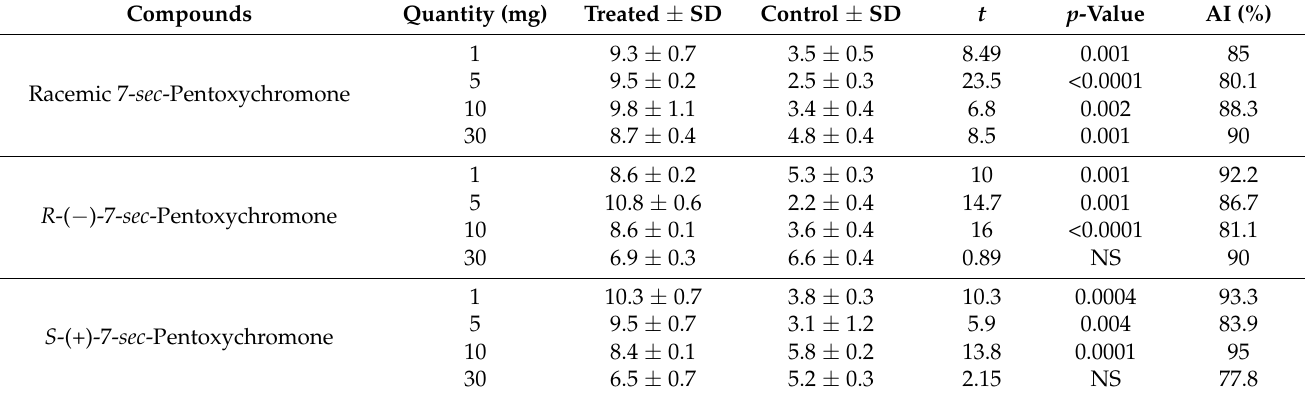
Table 18. T -test comparison of the average numbers of mosquitoes in the two zones: control and treated with racemic 7- sec -pentoxychromone ( 11 ), R -( − )-7- sec -pentoxychromone ( 16 ), and S -(+)-7- sec -pentoxychromone ( 17 ). Compounds Quantity (mg) Treated ± SD Control ± SD t p -Value AI (%)